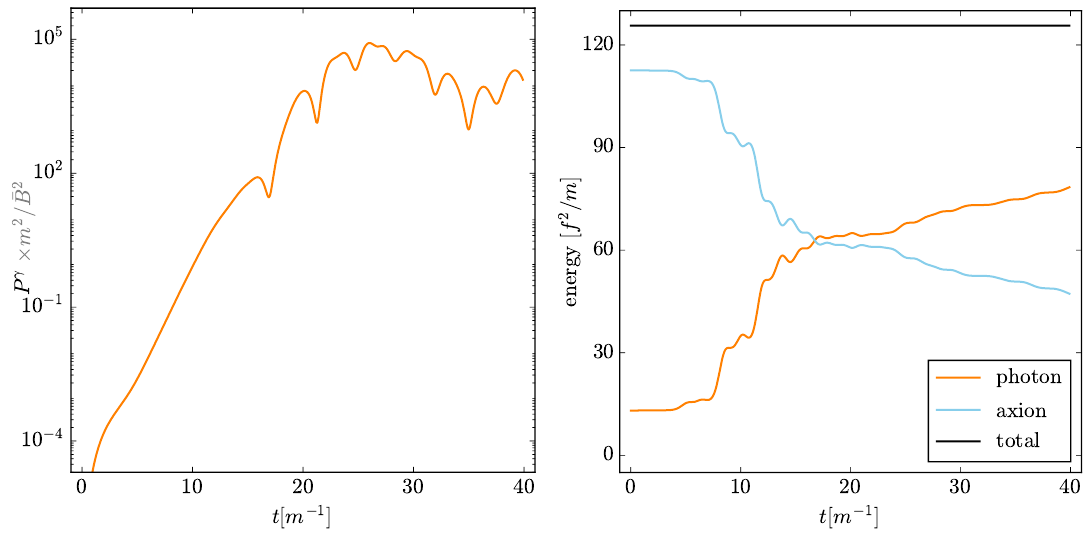
Figure 10 . Power radiated by a dense soliton for large effective coupling C = 1 . 7 (left panel). In this regime the power grows exponentially with time, however backreaction eventually curtails this growth when the radiated electromagnetic energy becomes comparable to the initial energy of the soliton (right